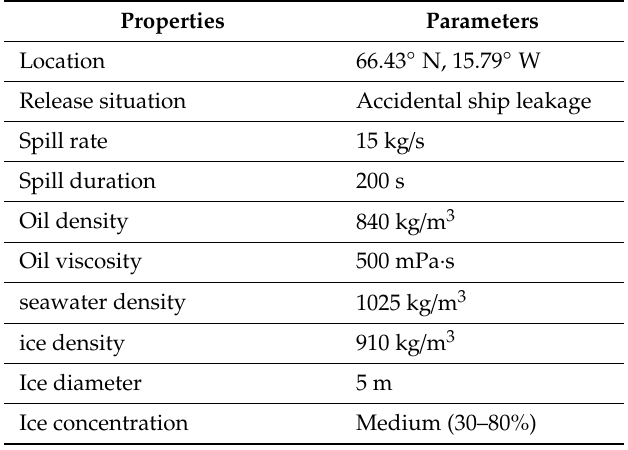
Figure 2. Computational domain of Icelandic waters. Table 1. The parameters used in the oil-spill model.